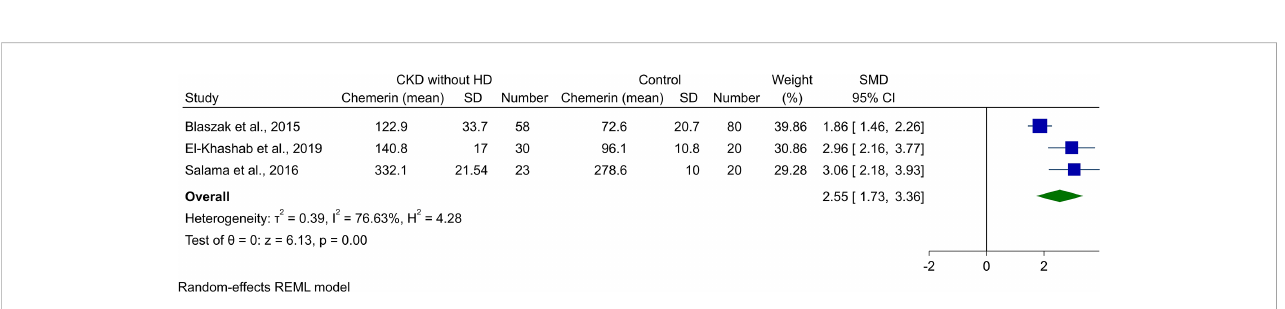
FIGURE 4 Forest plot for meta-analysis of chemerin levels in chronic kidney disease patients without hemodialysis compared to